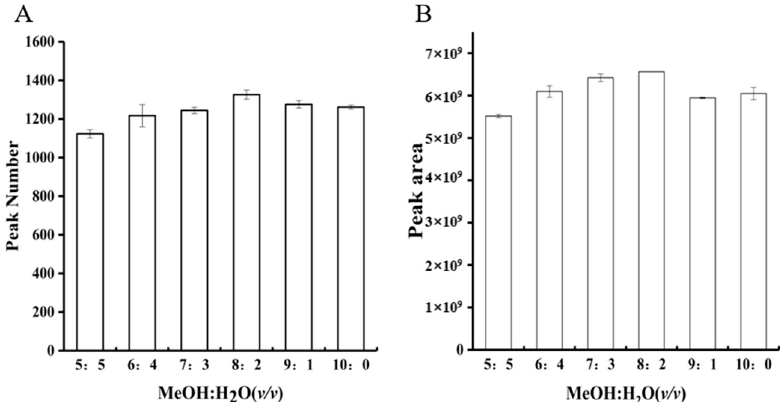
Figure 3. Histogram of the number of peaks and peak areas with different proportions of methanol and water. ( A ) Total number of peaks of the flue-cured NTL leaves extracted by different proportions of methanol and water; ( B ) total number of peak areas of the leaves extracted by different proportions of methanol and water.